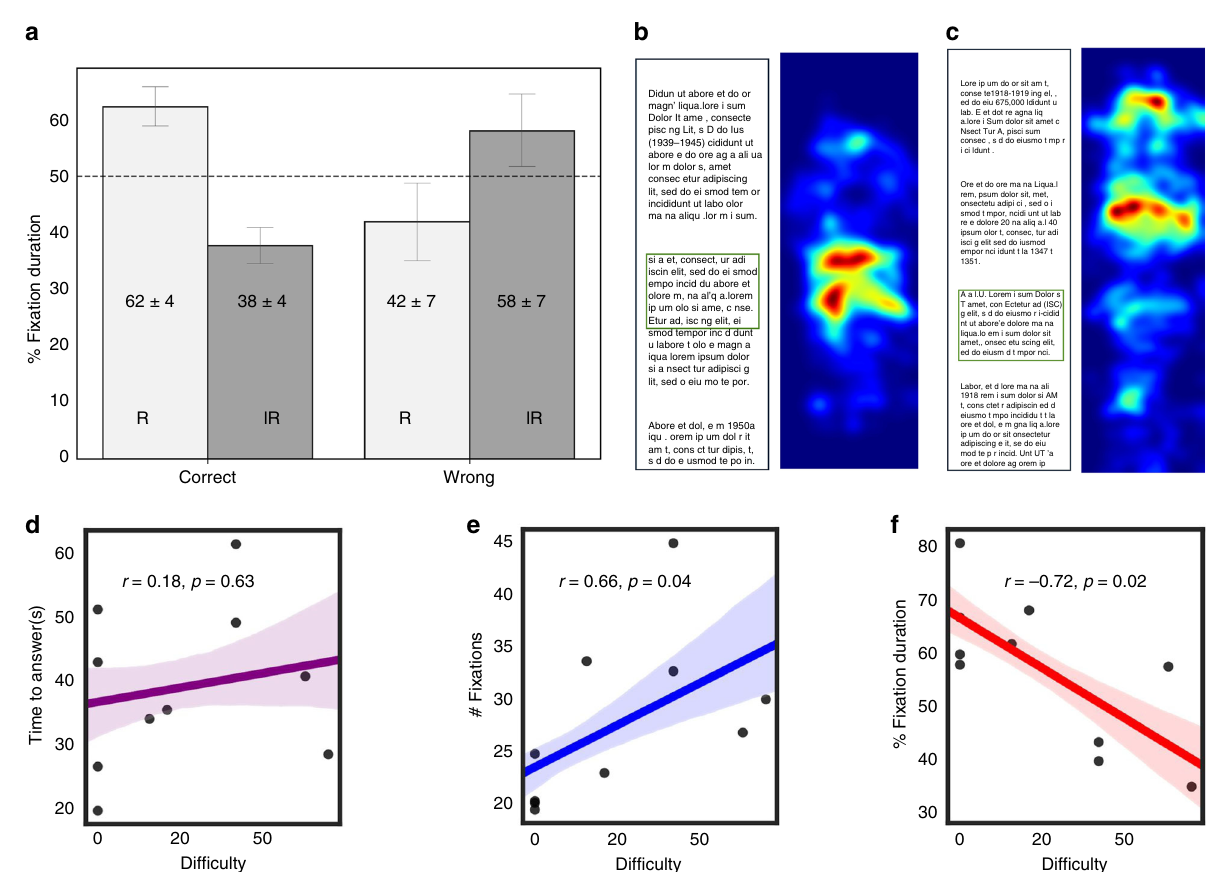
Fig. 9 Effect of reading comprehension dif fi culty on gaze for factual tasks. a Barplot shows % fi xation duration on the relevant portion of the passage (normalized by height) when participants answered the factual question correctly vs. not. Error bars denote the mean ± s.e.m. ( n = 53, 13 tasks for correct vs. wrong responses). b Example of fi xation heatmap for easy factual task; c dif fi cult factual task. d – f Scatterplots showing different metrics as a function of task dif fi culty. d Time to answer the question in seconds (includes time spent reading the question and the passage); e number of fi xations on the passage; f percentage time on relevant region, computed as the % total fi xation duration on the relevant portion of the passage (normalized by height). Statistical correlation reported is the Spearman ’ s rank correlation coef fi cient ( n = 10 tasks); two-tailed one sample t -test. The con fi dence band represents the bootstrapped 68% con fi dence